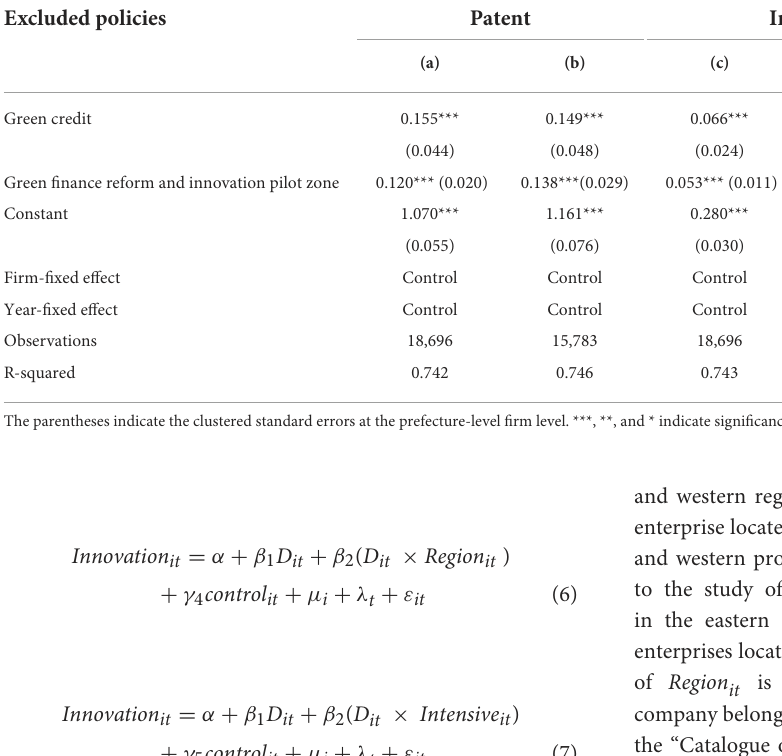
TABLE 7 Results of excluding the impact of other